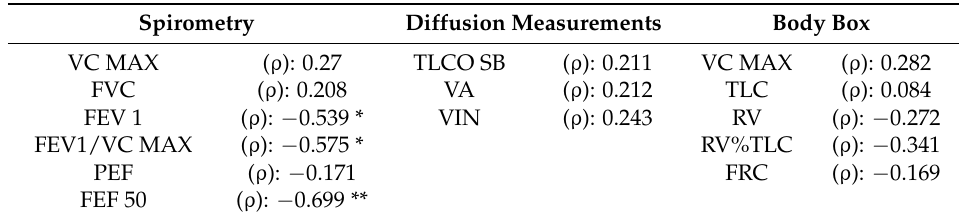
Table 3. Correlation of serum sumBDE (ng/g fat) with lung function parameters. Spirometry Diffusion Measurements